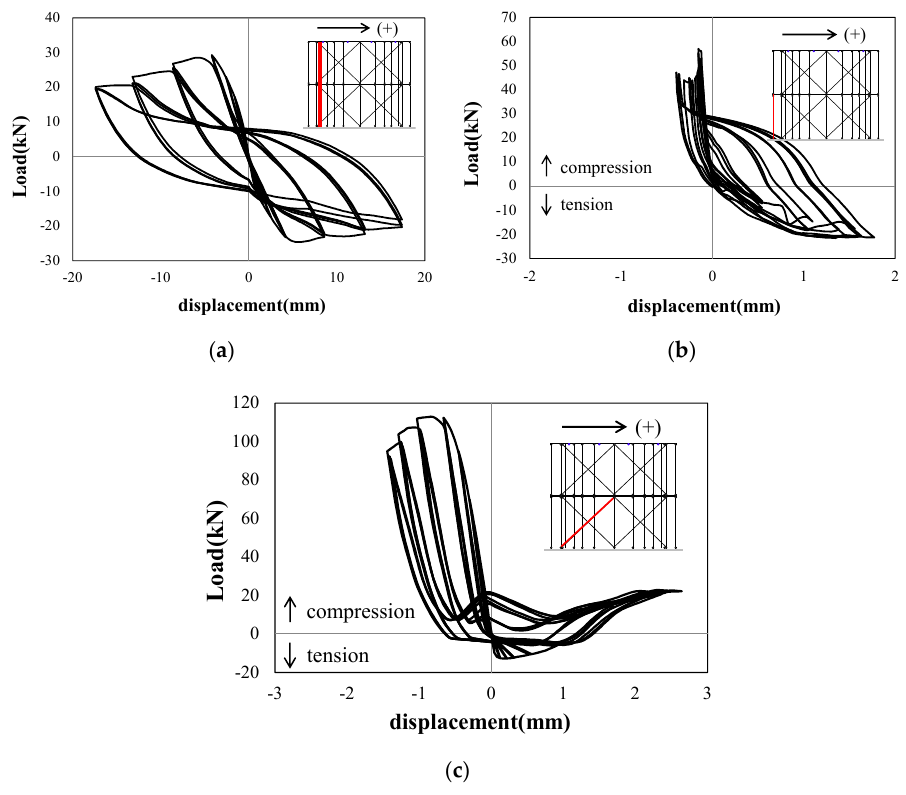
Figure 19. Estimated load–displacement responses of elements in Specimen FB: ( a ) column; ( b ) longitudinal element; ( c ) diagonal element.